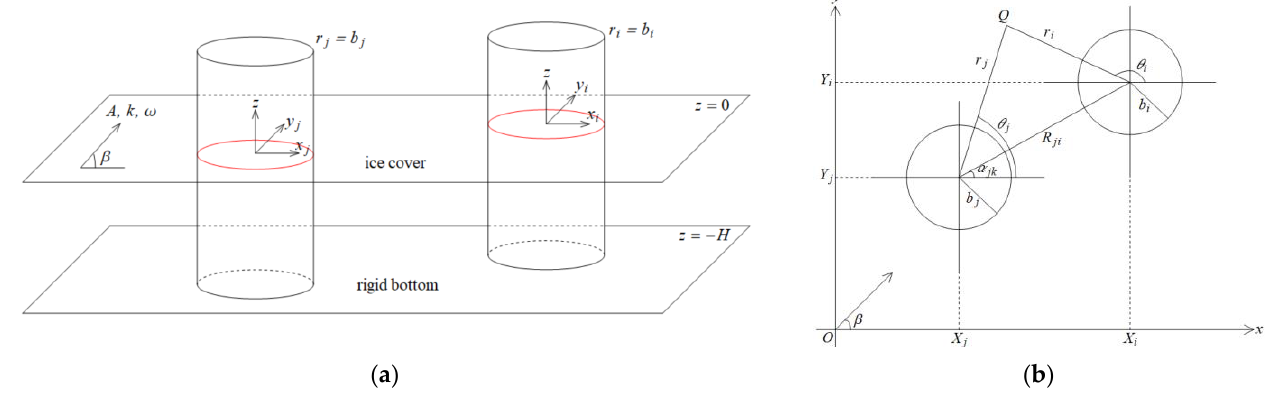
Figure 1. ( a ) Sketch of the problem ( b ) Coordinate system.